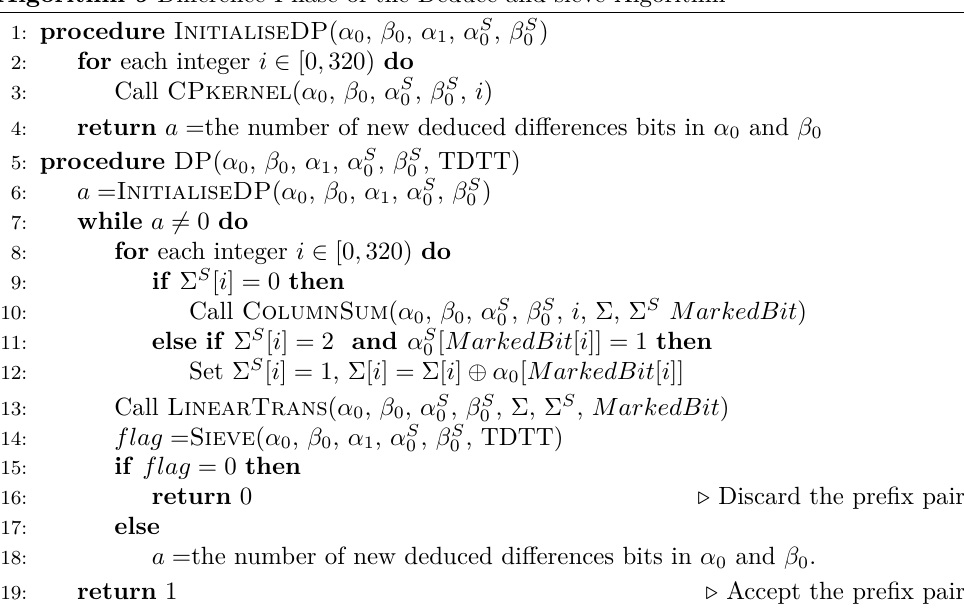
Algorithm 9 Difference Phase of the Deduce-and-sieve